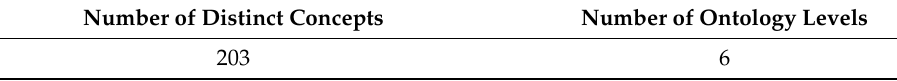
Table 6. Characteristics of the constructed hotel ontology